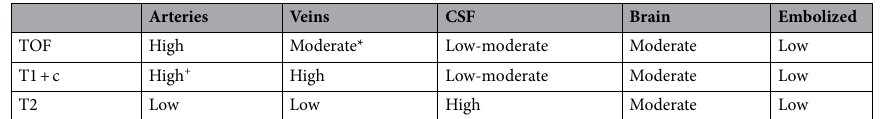
Arteries Table 2. Typical relative voxel intensities for each histological class for each of the MR sequences used in the study. * Early draining veins can have high intensity signal on TOF. + arterial intensity can be variable on T1 + c.